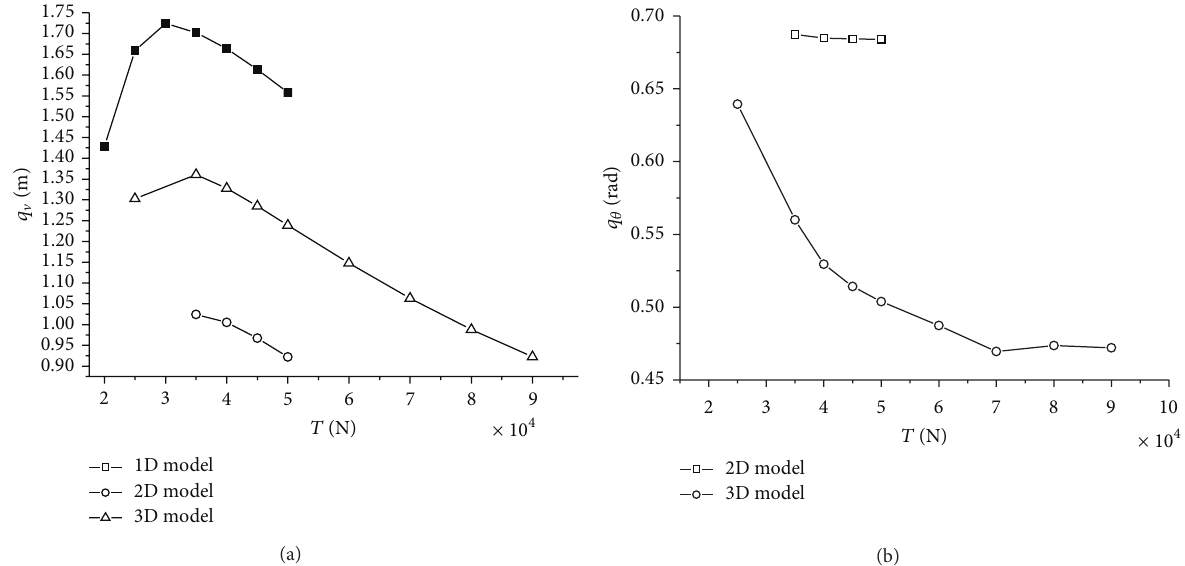
Figure 9: The influence of the initial tension on the galloping amplitude: (a) vertical amplitude and (b) torsional amplitude.